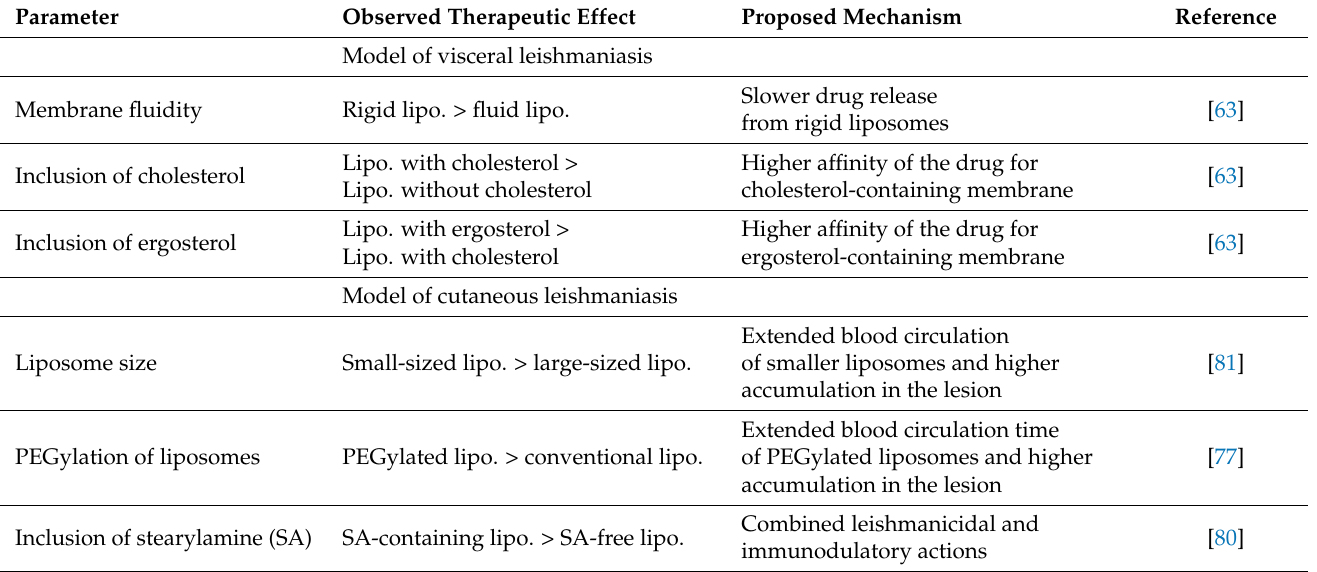
Table 1. Factors affecting the therapeutic efficacy of liposomal AmB in murine models of VL and CL, after parenteral